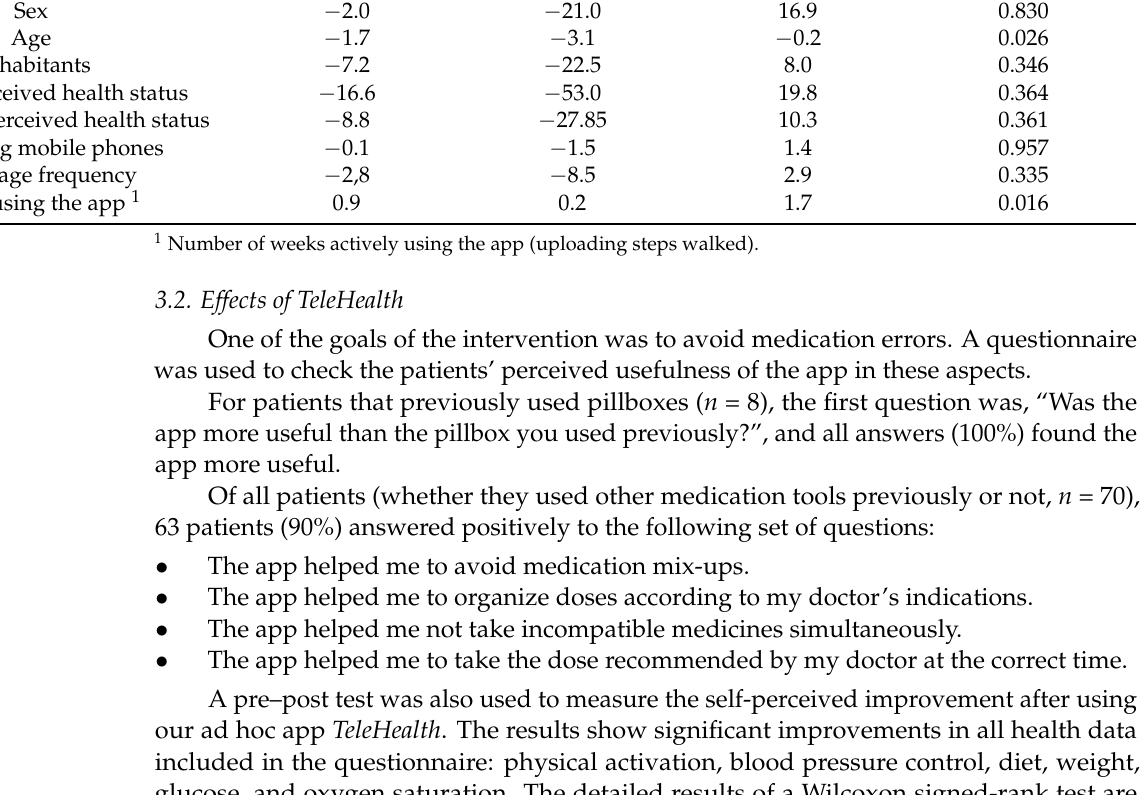
Table 2. Fulfillment of health objectives. Health Objective Fulfillment % Adherence to treatment 98 Oxygen saturation 82 Diastolic blood pressure 81 Systolic blood pressure 75 Diet 64 Heart rate 64 Steps walked 60 Glucose 57 Distance walked 57 Weight 48 Average 77